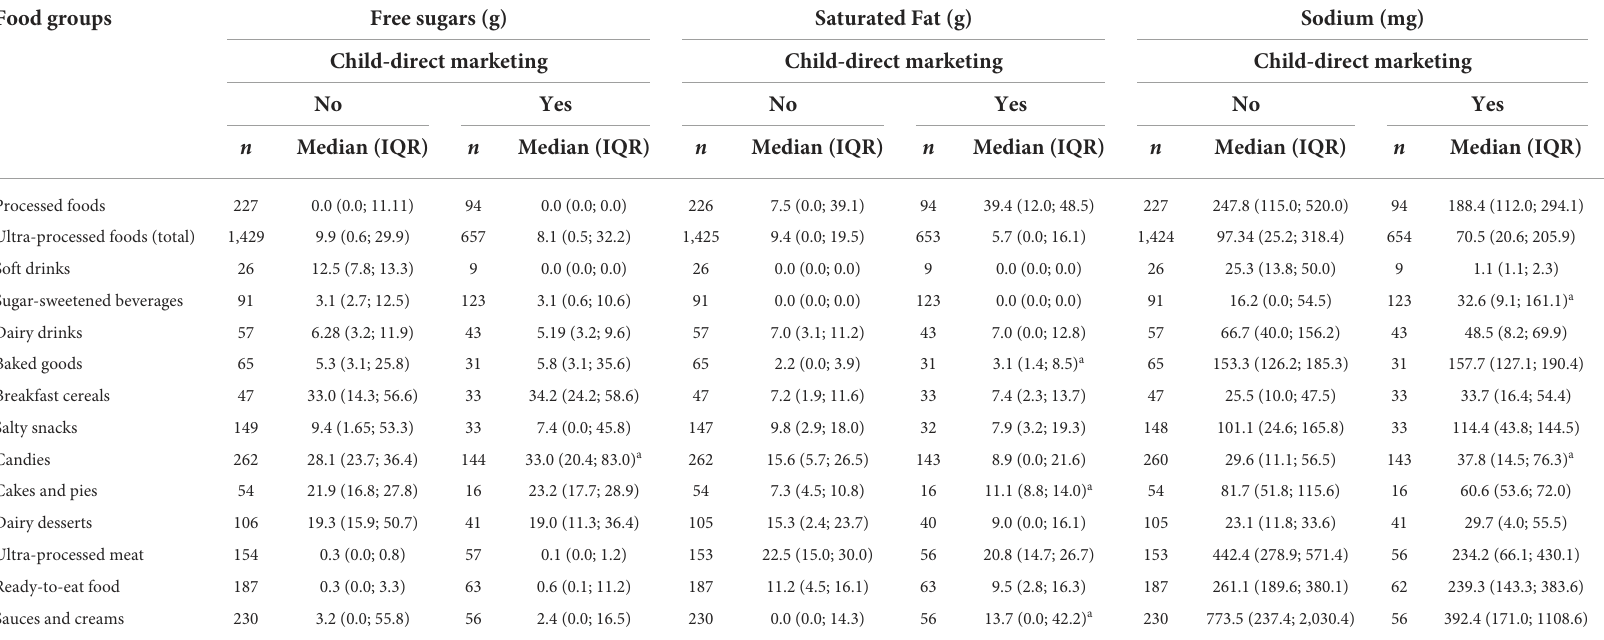
TABLE 2 Median and interquartile range for the content of free sugars, saturated fat, and sodium per 100 kcal in processed and ultra-processed foods by the presence and absence of child-directed marketing (Brazil, 2017). Food